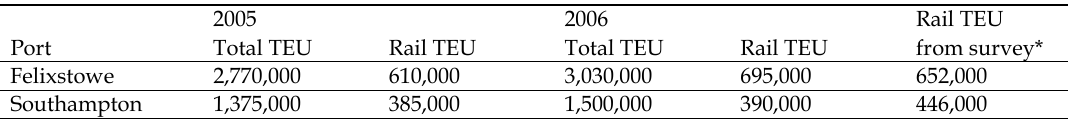
Table 2. Comparison between published statistics and survey estimates of rail-based container flows (in TEU) at Felixstowe and